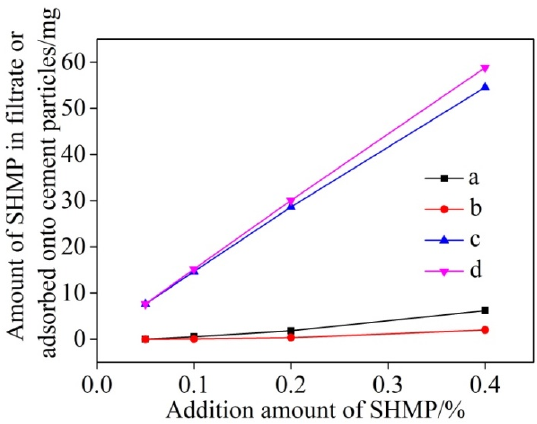
Figure 1. Amounts of SHMP in the filtrate after respectively: 5 min (a) and 30 min (b) stirring, and those adsorbed onto cement particles after respectively: 5 min (c) and 30 min (d) stirring.